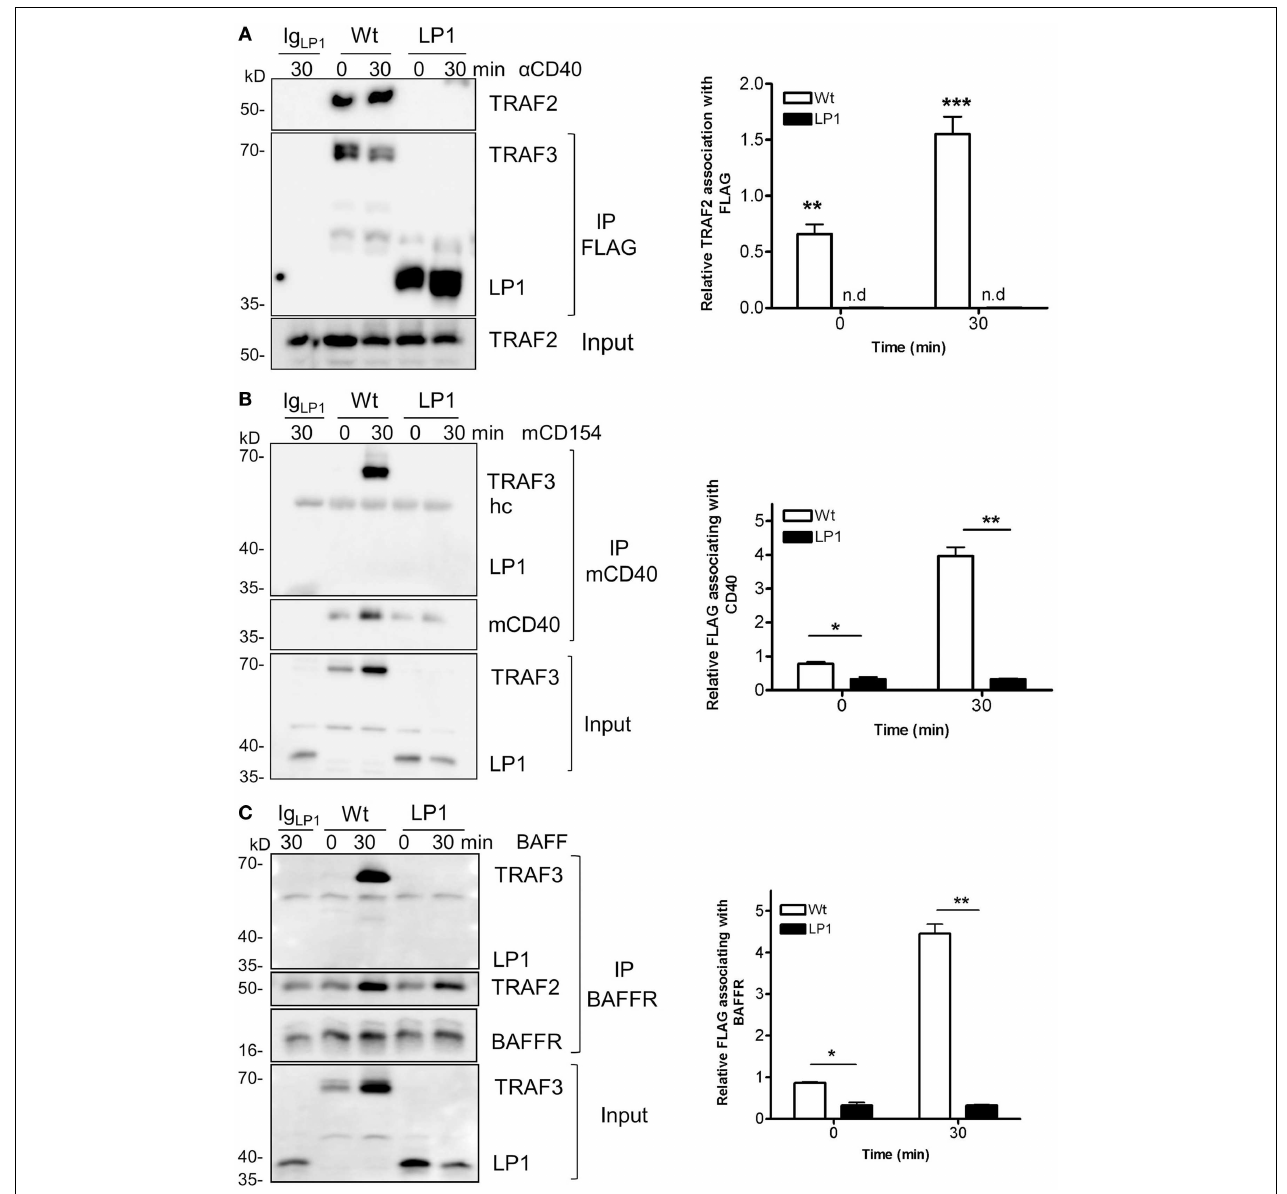
lysates and subjected to immunoprecipitation with anti-mCD40 Ab as in Section “Materials and Methods.”Western blots were probed for FLAG and CD40. Graph represents quantification of mean values of relative amounts of TRAF3 associating with membrane CD40 from two different experiments. * p = 0.03; ** p = 0.005. (C) Cells were untreated or cultured with 500ng/ml of BAFF as indicated. Detergent-insoluble membrane fractions were isolated as above and anti-BAFFR Ab were used to immunoprecipitate the receptor signaling complex.Western blots of immunoprecipitates were probed for FLAG and BAFFR.The bar graph shows quantification of mean relative amounts ofTRAF3 associated with BAFFR, from two different experiments. * p = 0.03; ** p =